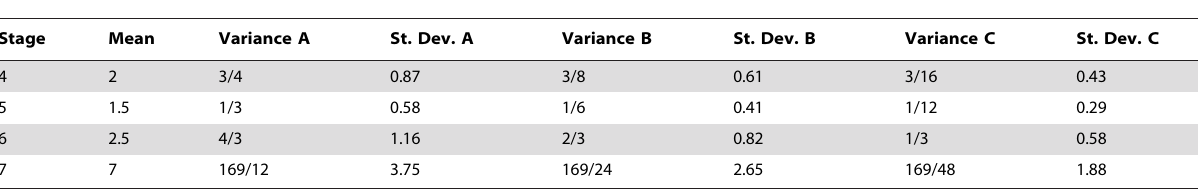
Table 1. Test Distributions for AD simulations.